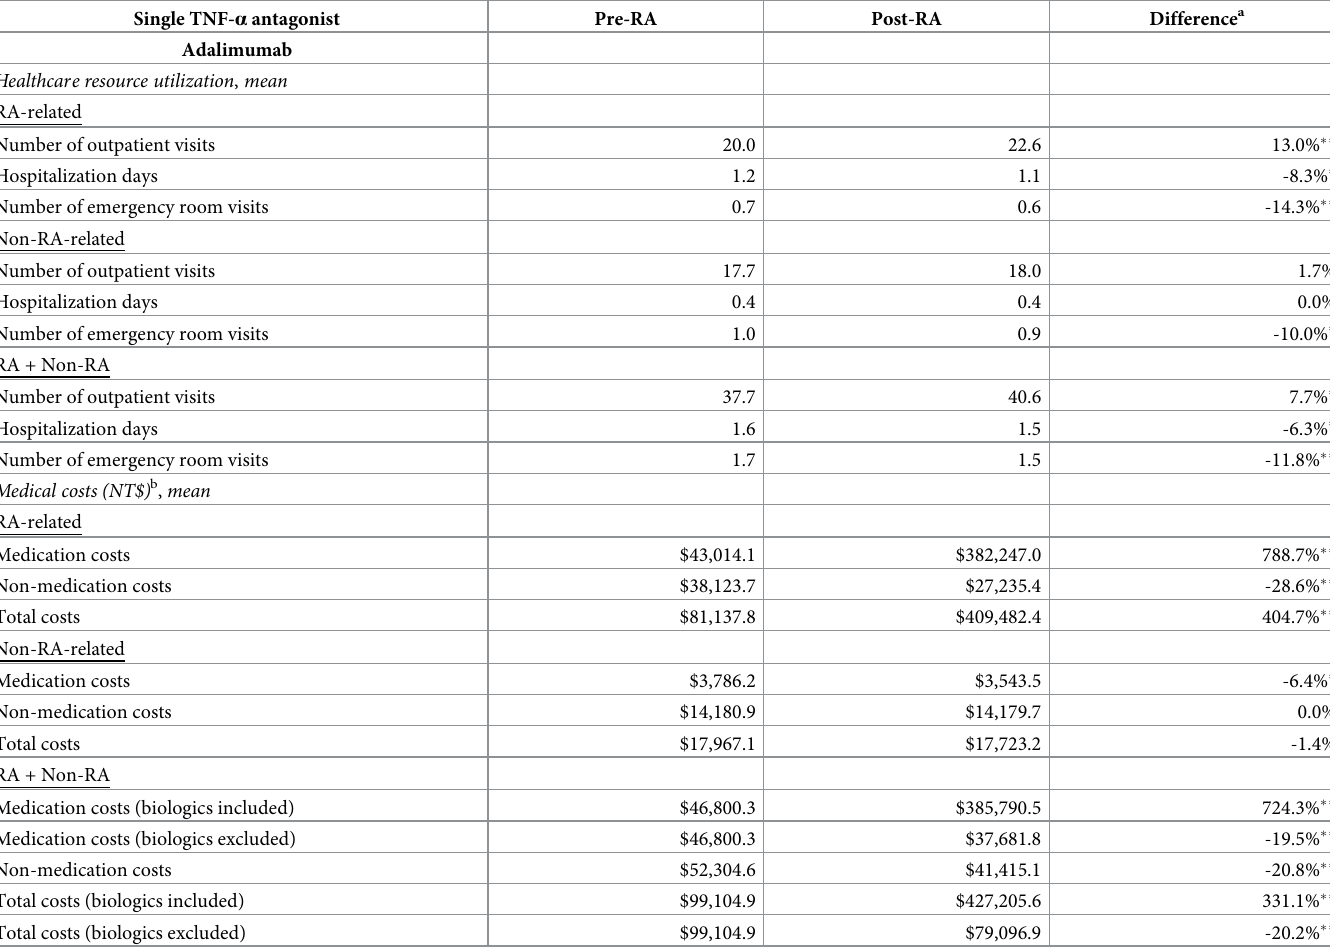
Table 3. Differences in healthcare resource utilization and direct medical costs of patients with rheumatoid arthritis (RA) before and after the use of single biologic